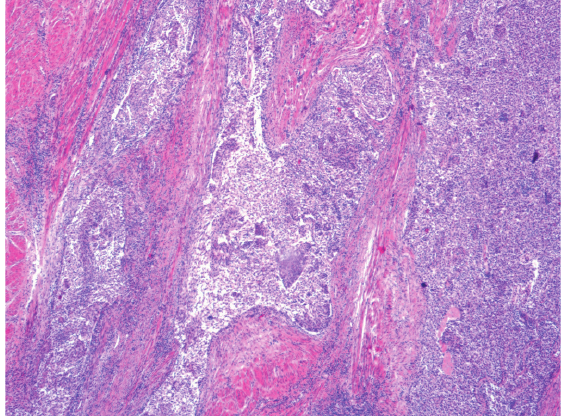
Figure 3. Low power view (×4 objective lens) of Hematoxylin and Eosin (H and E) stained bladder resection specimen showing the large nests of the invasive component of urothelial carcinoma with abundant interspersed stromal